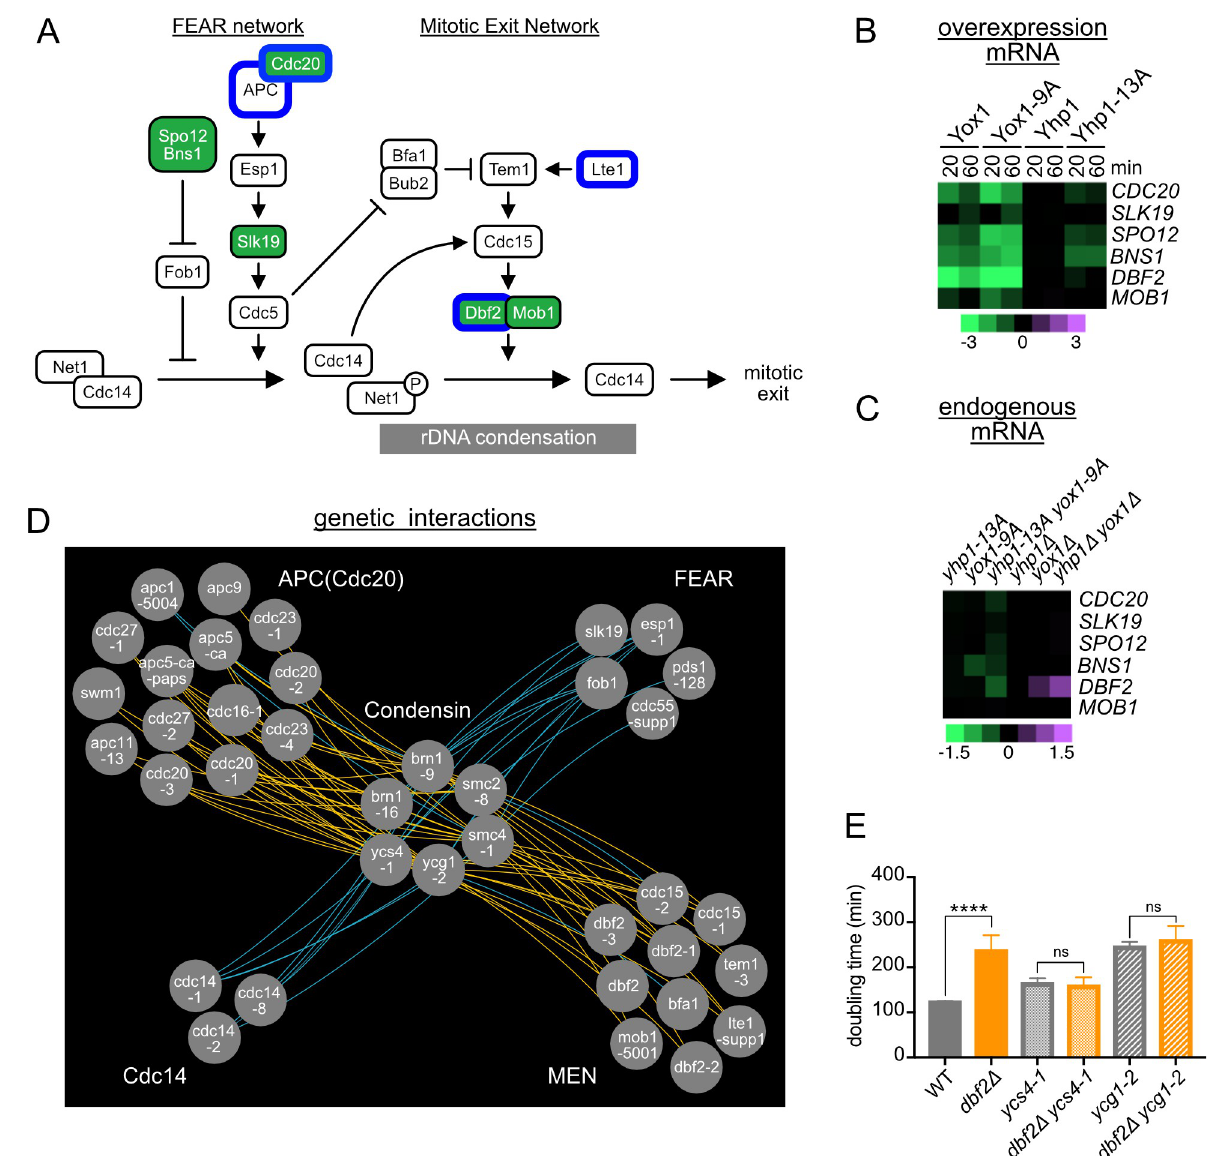
Fig 6. Increased repression of mitotic exit genes by yhp1-13A yox1-9A improves the fitness of condensin mutants. (A) Diagram of the FEAR and MEN pathways that control mitotic exit. Regulators colored green are repressed by Yhp1/Yox1. Regulators circled in blue display negative genetic interactions with yhp1-13A yox1-9A . (B) Gene expression of Yhp1/Yox1 target genes that regulate mitotic exit, following acute overexpression of the indicated proteins, from RNAseq experiments presented in Fig 2. (C) Expression of genes from (B) in strains expressing the indicated Yhp1/Yox1 mutants from their endogenous promoters or deleted for the indicated TFs, from experiments presented in S2 Fig. Note the difference in scale between (B) and (C). (D) Genetic interaction map highlighting significant genetic interactions between condensin and mitotic exit regulators. Yellow lines indicate positive interactions, blue lines indicate negative interactions. All interaction values are included in S1 Table. (E) Doubling times of strains with the indicated genotypes grown in rich medium at 28˚C. Shown is an average of n = 7–15 replicates, error bars indicate standard deviations. Significance was tested with an unpaired t-test, ���� p < 0.0001, ns = nonsignificant.